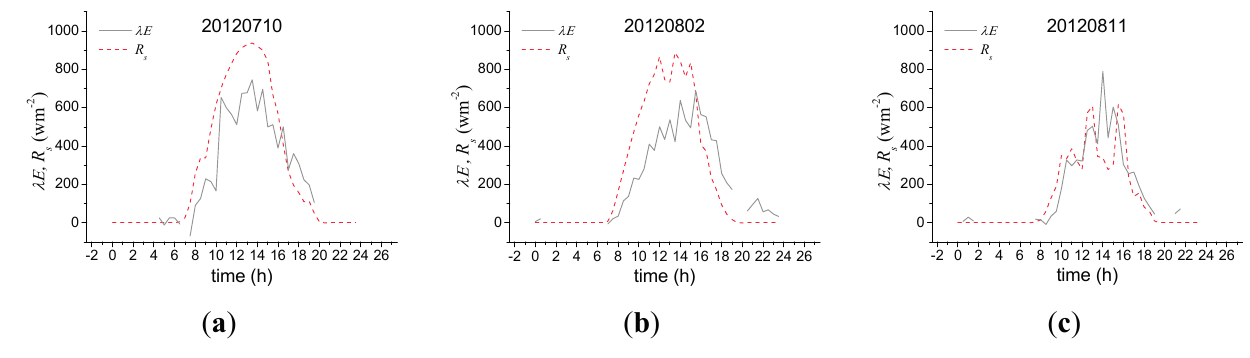
Figure 8. Comparison of λ E from observations of tower EC12 and the total solar radiation from AMS12 on ( a ) 10 July, ( b ) 2 August and ( c ) 11 August of